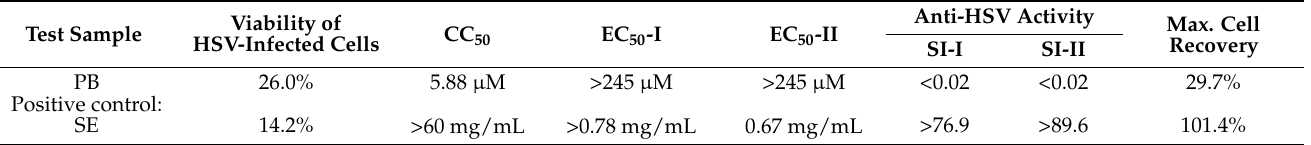
Table 4. Quantification of anti-HSV activity of pyoktanin.